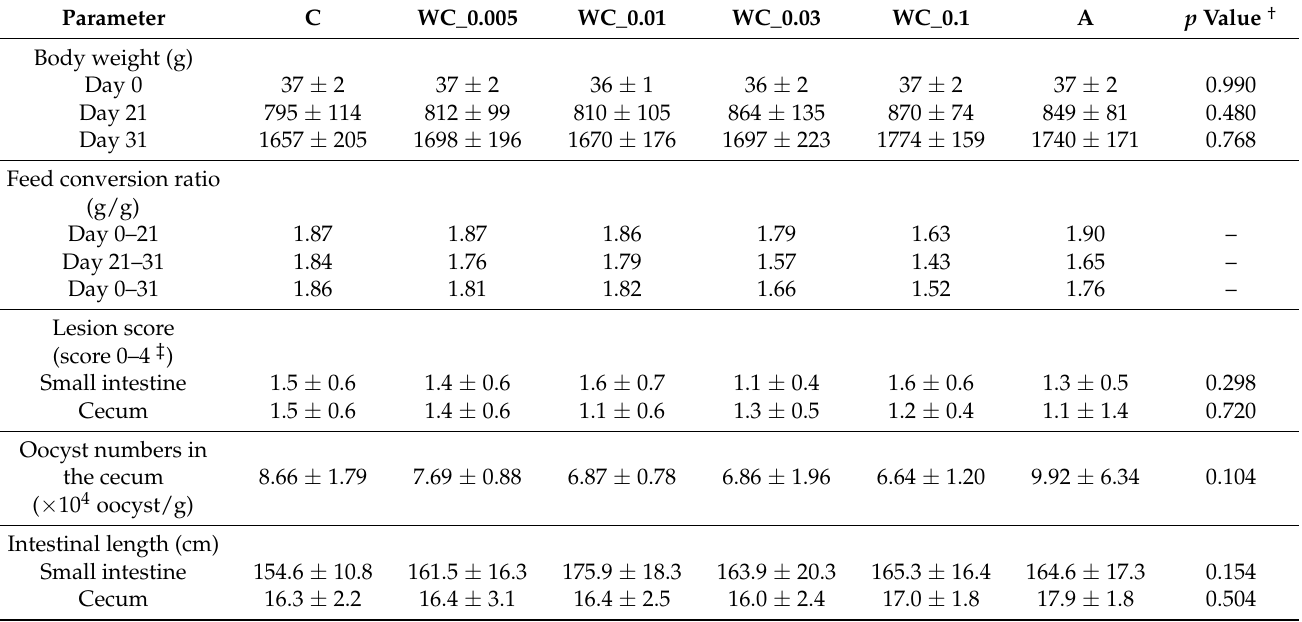
Table 1. The body weights, feed conversion ratios, lesion scores, oocyst numbers in the cecum, and in the intestinal lengths of broiler chicks in Experiment